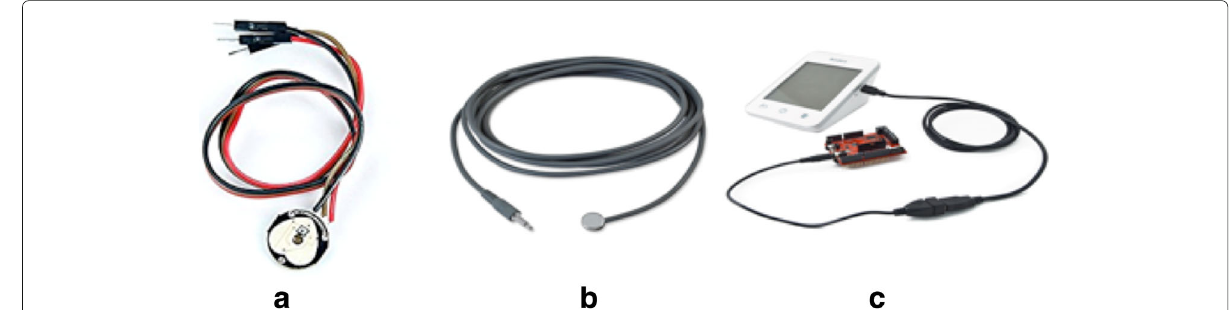
Fig. 3 a The WISE heartbeat sensor. b The WISE body temperature sensor. c The WISE blood pressure